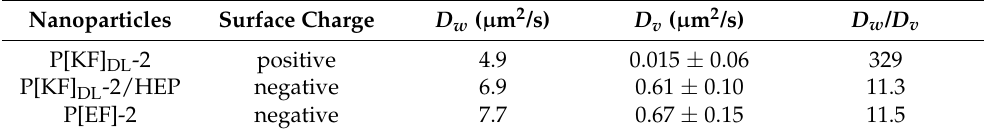
Table 3. Mobility of the tested anionic and cationic nanoparticles in the vitreous humor.